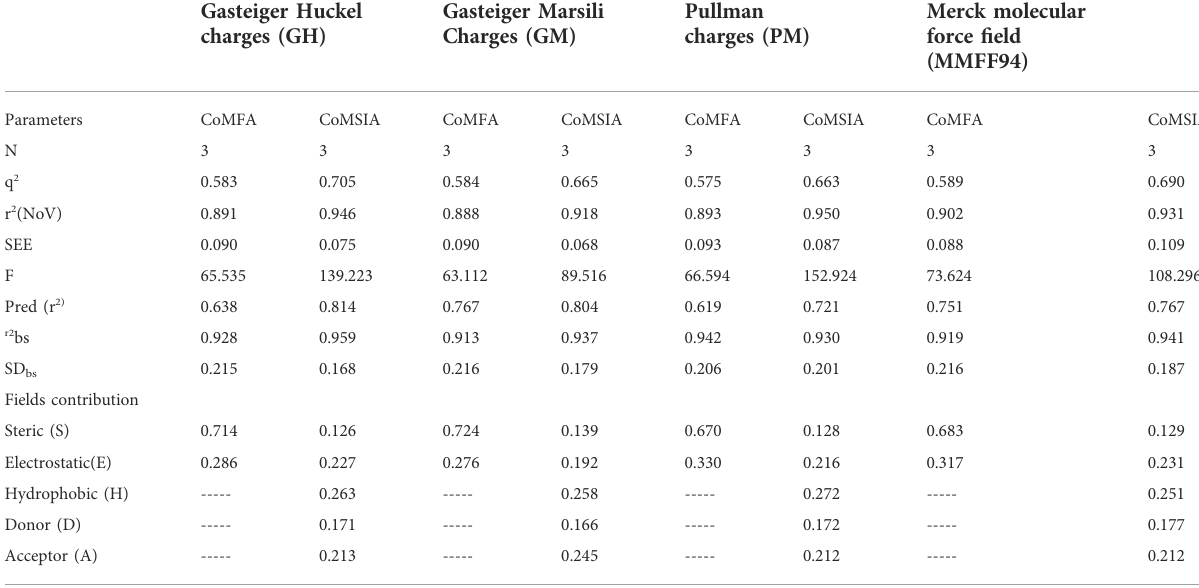
TABLE 1 Statistical parameters of structure based CoMFA and CoMSIA models with different charge schemes.